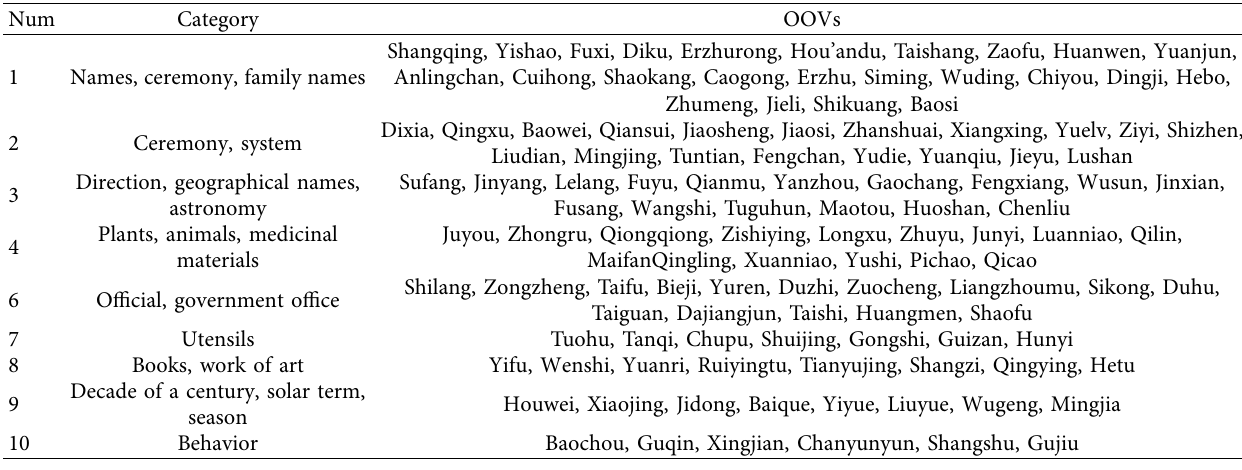
Table 1: A randomly selected part of OOVs in Temporal Imperial Encyclopedia extracted through mutual information and adjacency entropy.